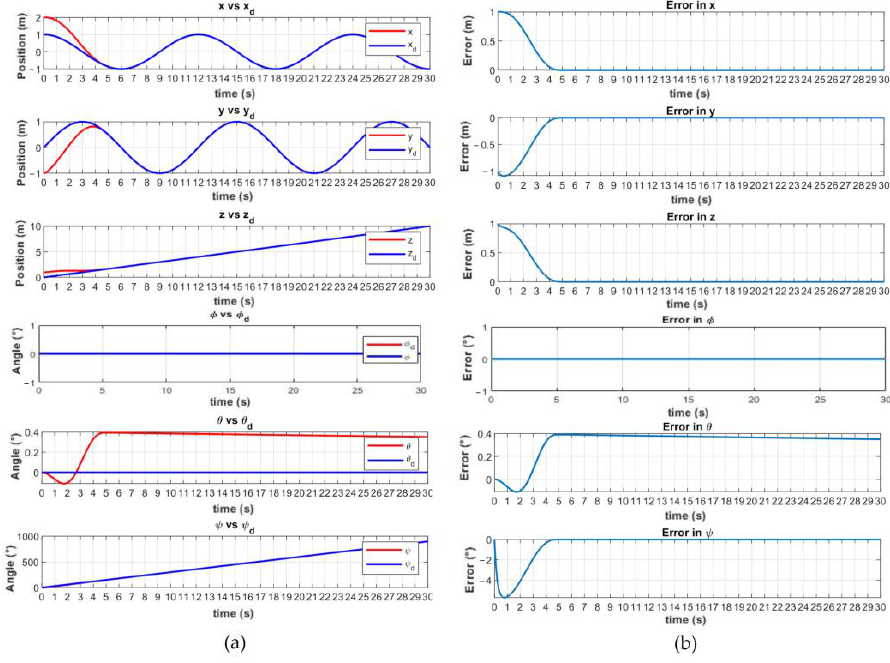
Figure 5. Results with t b = 5 s. ( a ) Trajectory tracking. ( b ) Position tracking errors.